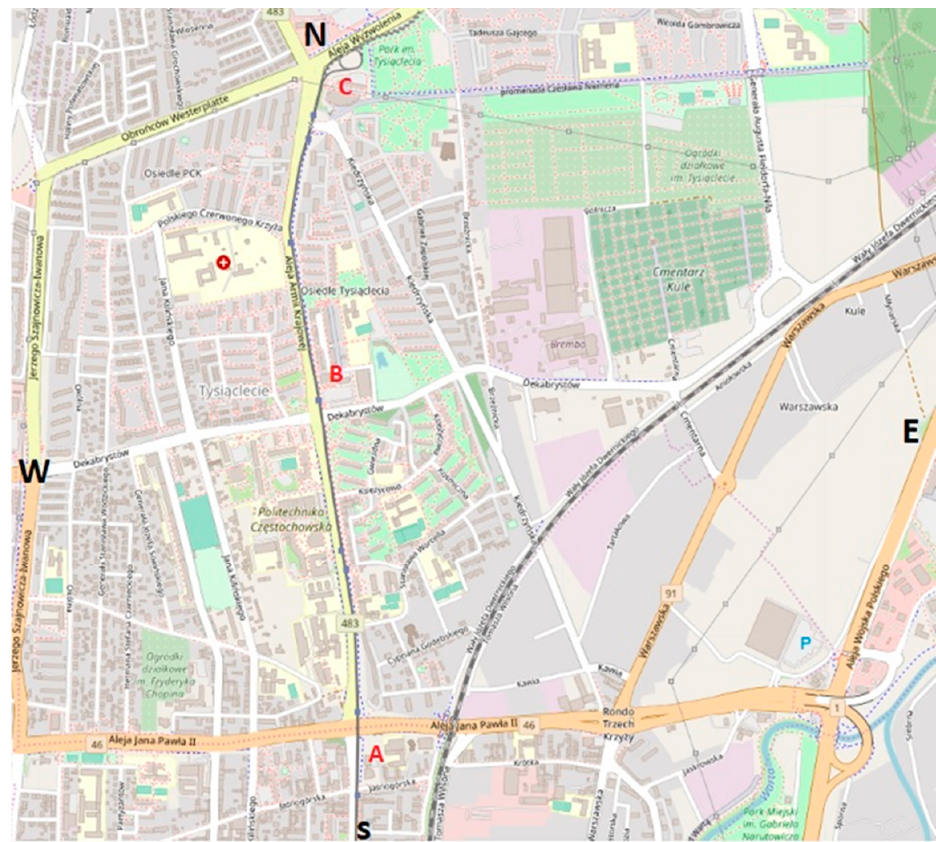
Figure 1. Map of area covered by the study.